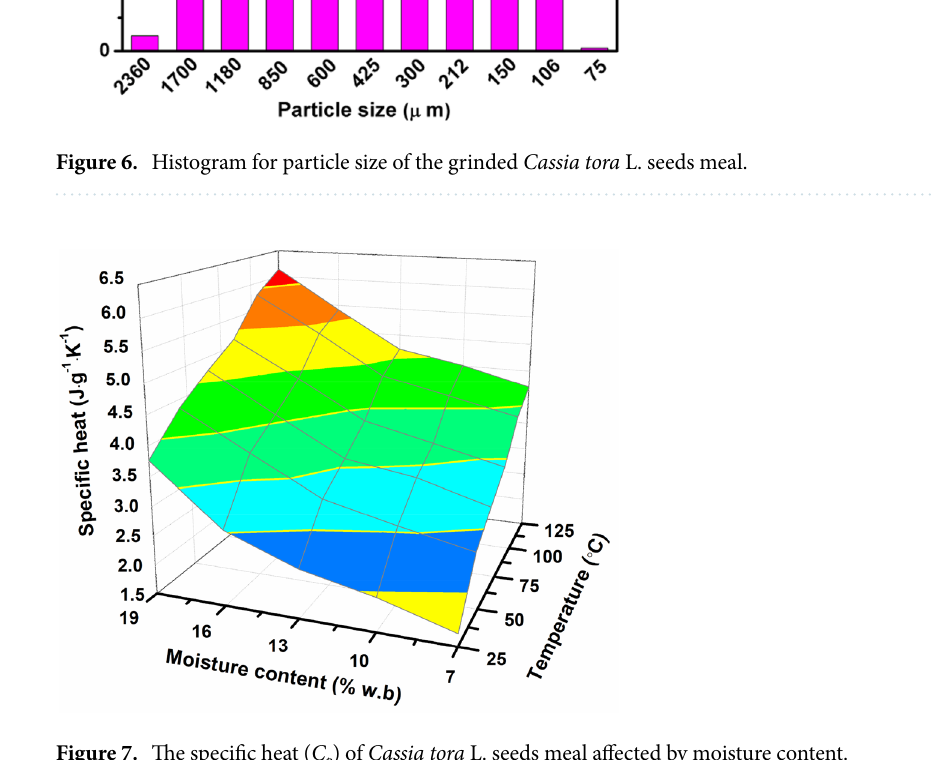
Figure 7. The specific heat ( C p ) of Cassia tora L. seeds meal affected by moisture